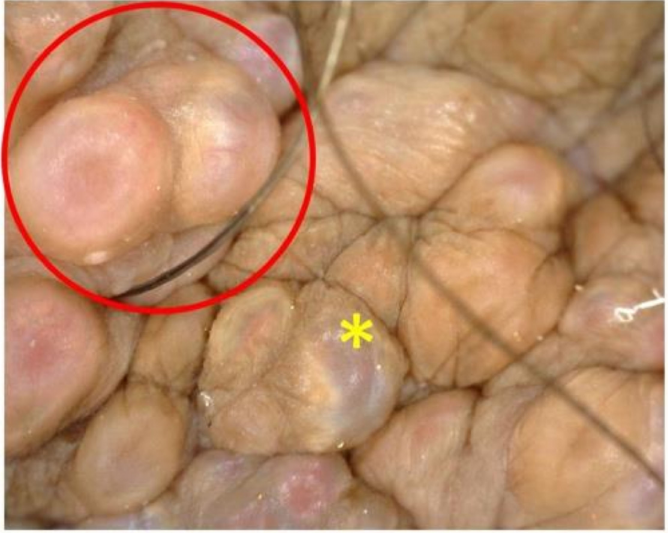
Figure 3. Pale blue lacunae (yellow *) and nodules with radially arranged linear vessels (red circle). Histopathology of scrotal vesicles (4 mm punch biopsy sample was sent to an ISO- certified private histopathology laboratory) revealed multiple dilated lymphatics along superficial perivascular lymphocytes and few dilated blood vessels (hematoxylin and